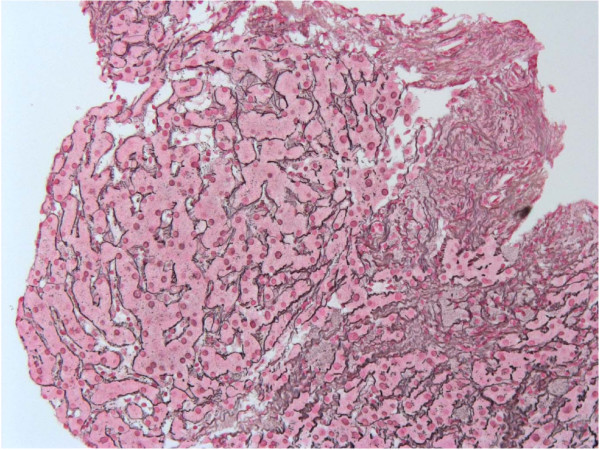
A liver biopsy performed in September 2006 shows in the reticulin stain an altered architecture with enlarged hepatocytes arranged in small nodules (×400).